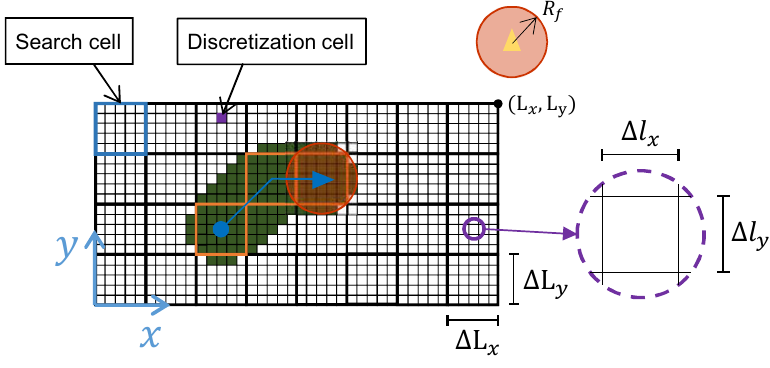
Figure 1. Scheme of the scenario considered. Each quadcopter has a sensor footprint with a radius R f . The area, with lengths L x = 6.4 m and L y = 4.0 m, is divided into search and discretization cells, in blue and purple respectively. In the figure, the agents has flown between the three centers of the orange-marked cells. In dark green, the observed discretization cells during the